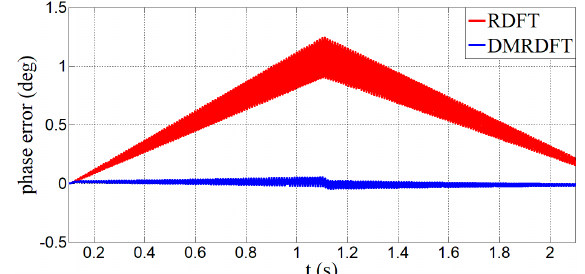
Figure 7. Dynamic effect on frequency tracking of DMRDFT with the harmonic.